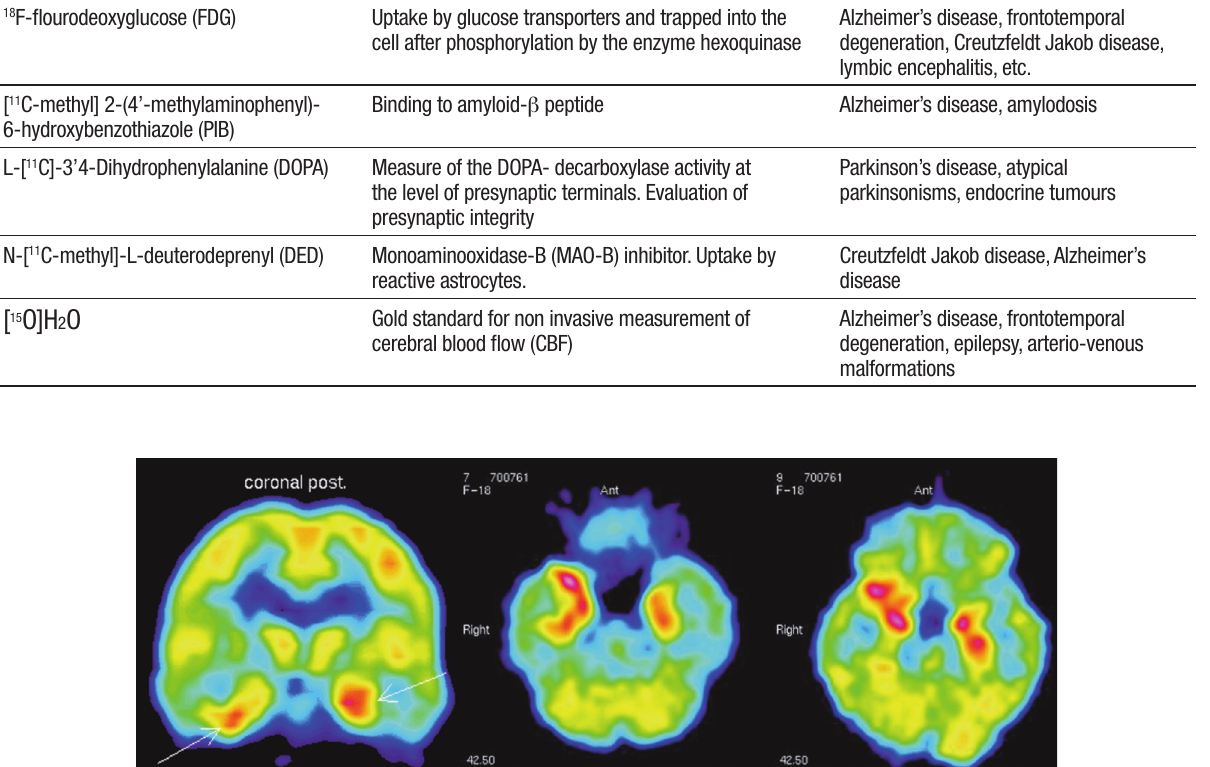
Table 1. PET molecular probes and their clinical use.